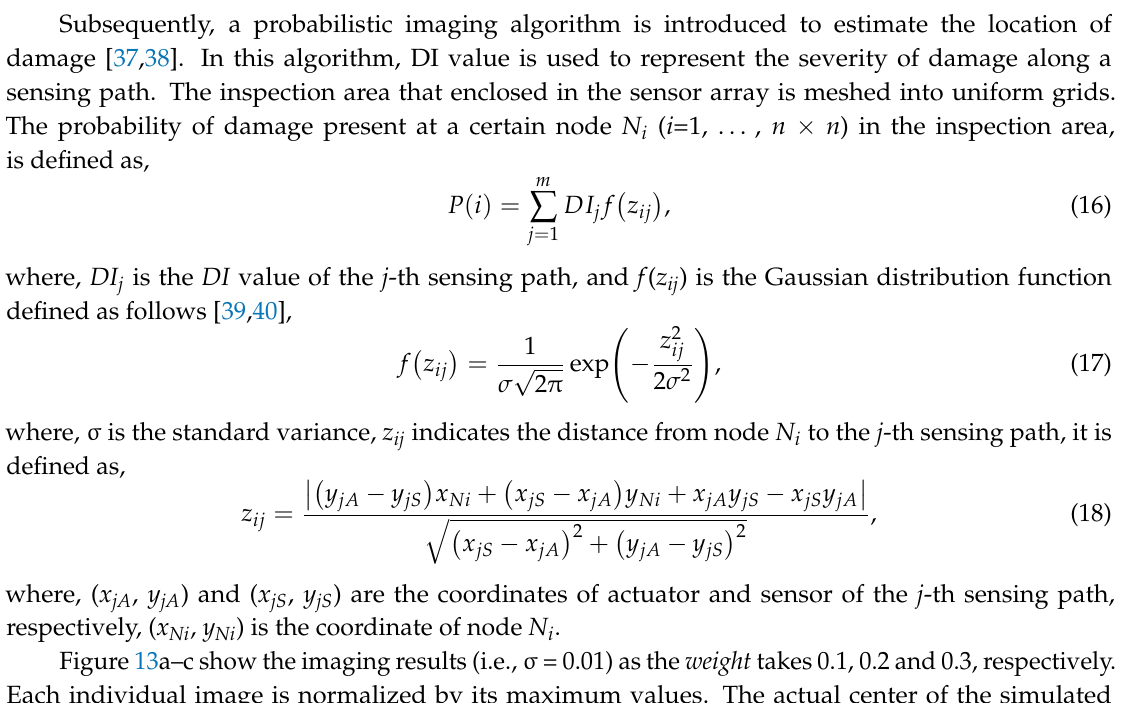
Figure 12. ( a ) The comparison between the reconstructed signals and the original input signal of Path 1 and Path 2 and ( b ) the DI values of the 16 paths.